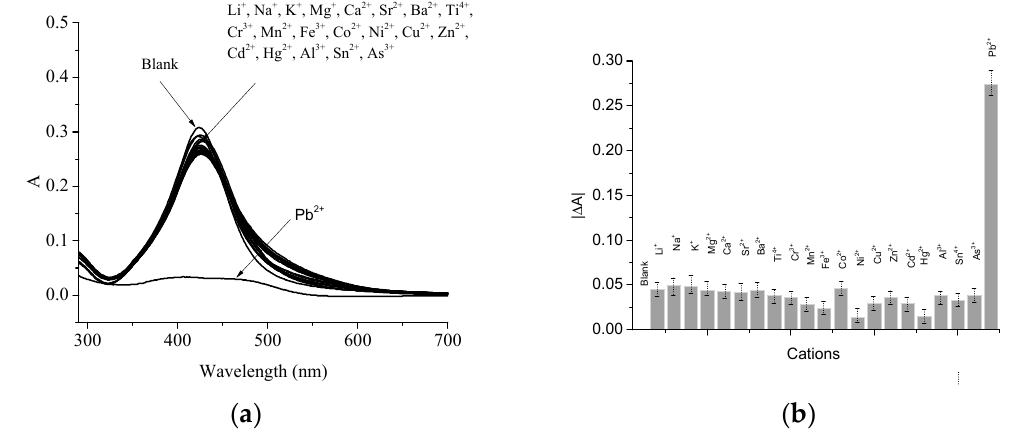
Figure 2. ( a ) Localized surface plasmon resonance (LSPR) absorbance spectra of colloidal AgNPs after addition of various cations at a concentration of 250 µg/mL, ( b ) calculated LSPR absorbance decrease after addition of the cations. The error bars were included as the measurement was repeated (n = 5).